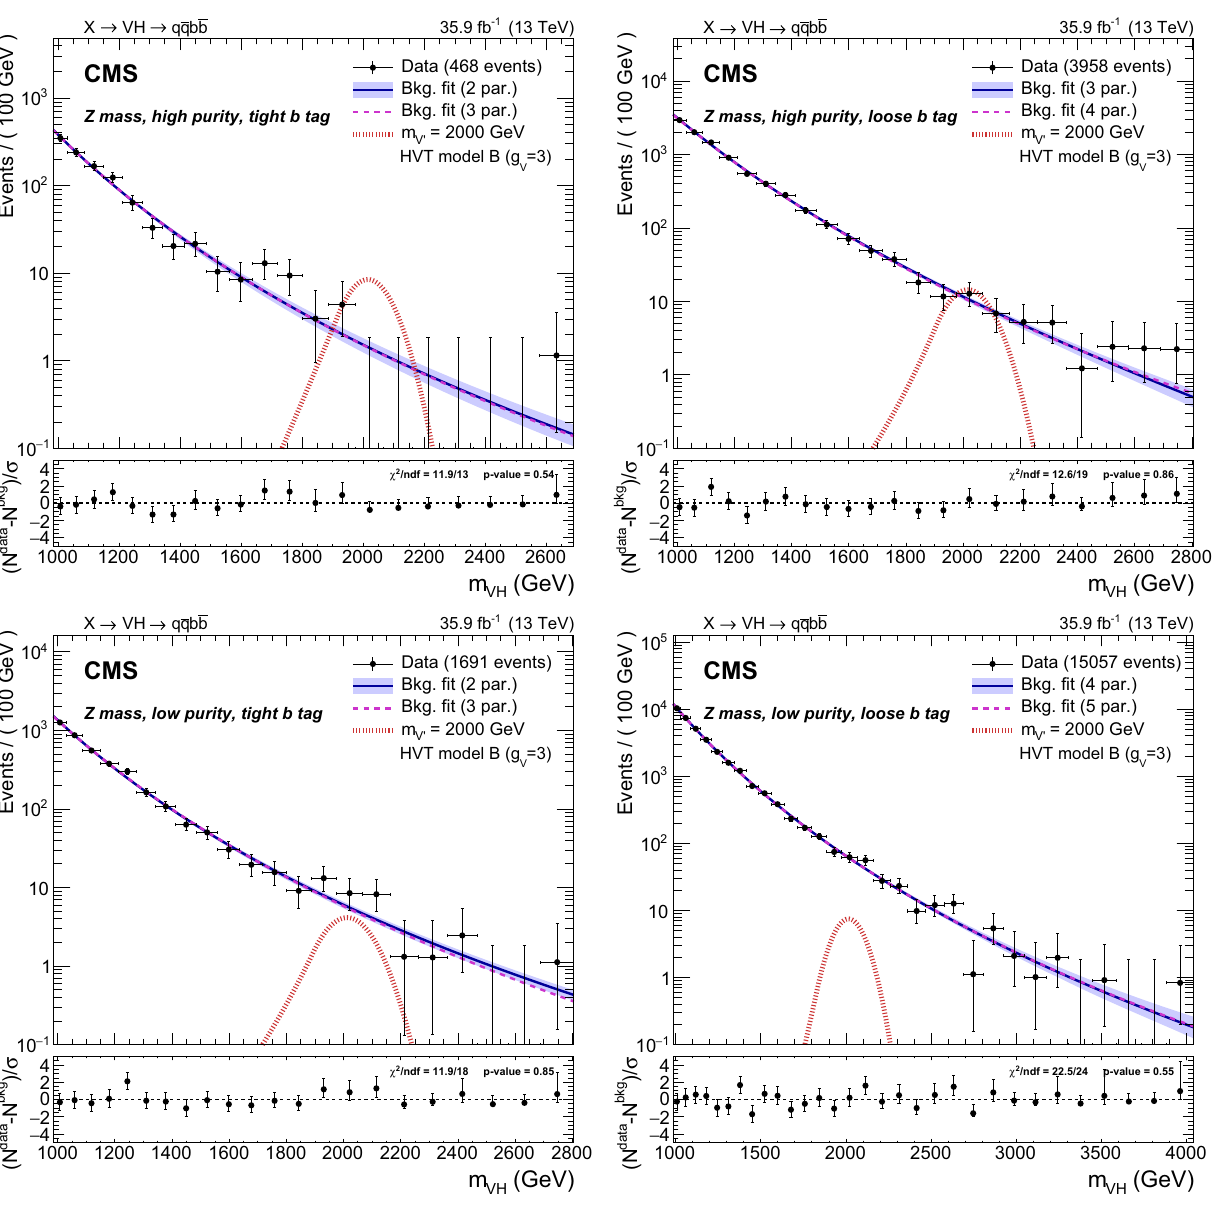
( N data − N bkg )/σ , where σ is the Poisson uncertainty in data. The hor- izontal bars on the data points indicate the bin width and the vertical bars represent the normalized Poisson errors, and are shown also for bins with zero entries up to the highest m VH event. The expected con- tribution of a resonance with m X = 2000 GeV, simulated in the context of the HVT model B, is shown as a dot-dashed red